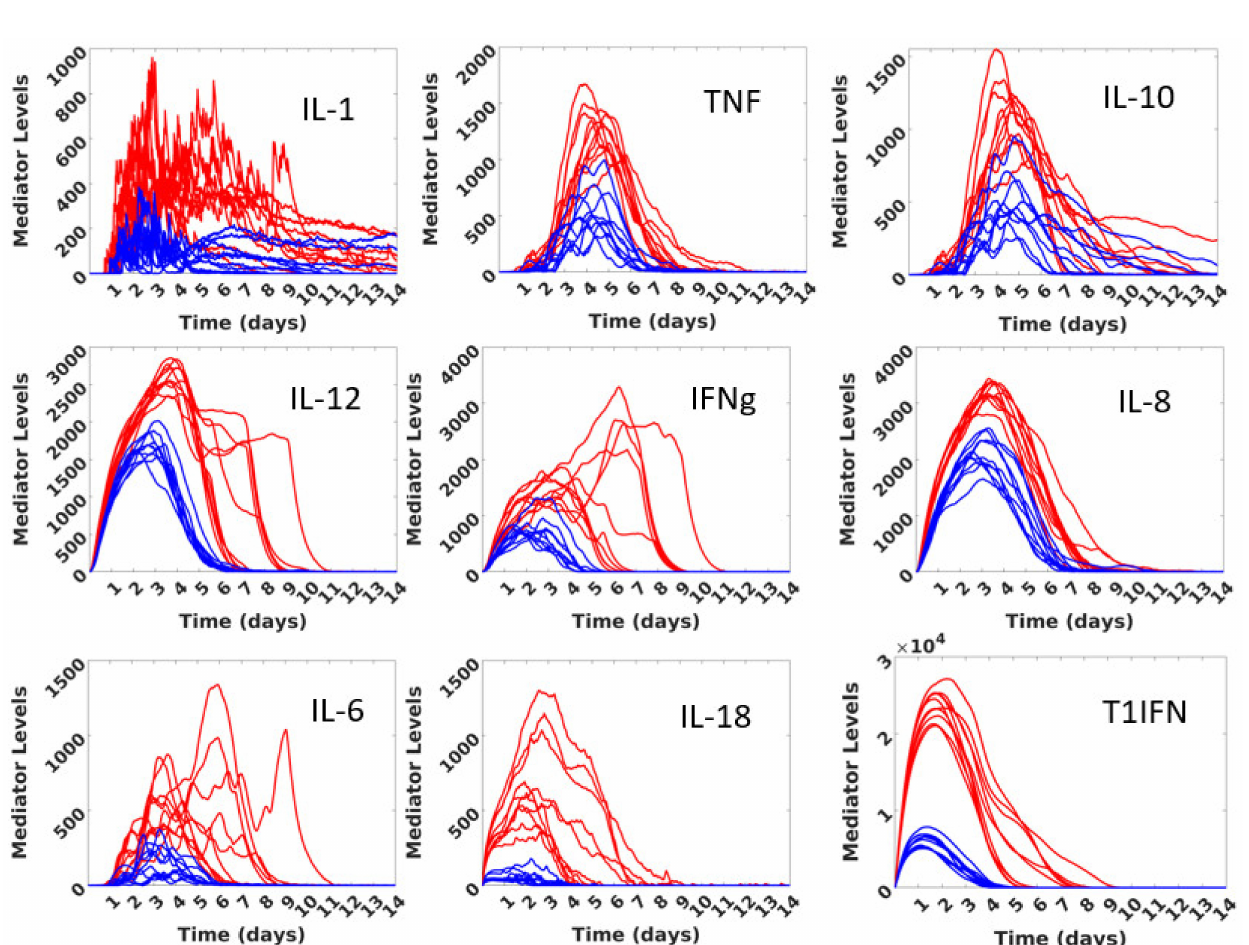
Figure A1. Trajectories for every represented mediator in the CBIABM, excepting PAF, ROS, and P/DAMPs; the reason these are not displayed is that they are very local mediators not generally or reliably measured systemically. The values on the Y -axes of these plots are unitless, with the rationale relayed in Appendix A. The blue lines are mediator trajectories from n = 10 stochastic replicates at an initial inoculum = 75 corresponding to moderate disease severity, whereas the red lines are mediator trajectories from n = 10 stochastic replicates at an initial inoculum = 150 corresponding to severe disease severity. Given the representation of a generic virus in the CBIABM, these plots all demonstrate plausible trajectories corresponding to the assumed onset of symptoms at ~3 days, with expected higher values and generally increased durations with greater initial inoculum and disease severity. Note that the absence of T cells in the current version of the CBIABM means their contributions to the levels of these mediators are not present and not reflected in these trajectories beyond ~day 7. These simulations also demonstrate the effect of stochastic processes in variation in the trajectories, consistent with the heterogeneity present within experimental data and clinical populations. IL-1 = interleukin-1, TNF = tumor necrosis factor, IL-10 = interleukin-10, IL-12 = interleukin-12, IFNg = interferon-gamma, IL-8 = interleukin-8, IL-6 = interleukin-6, IL-18 = interleukin-18, T1IFN = type 1